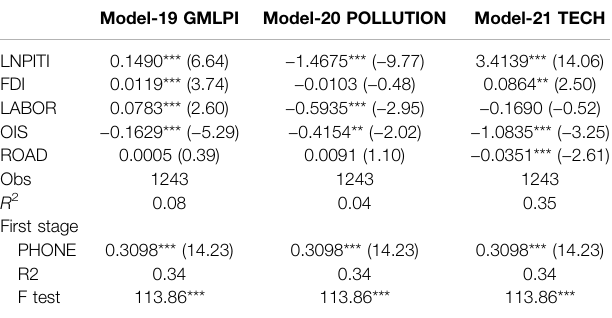
TABLE 7 | Estimation results of the instrumental variable